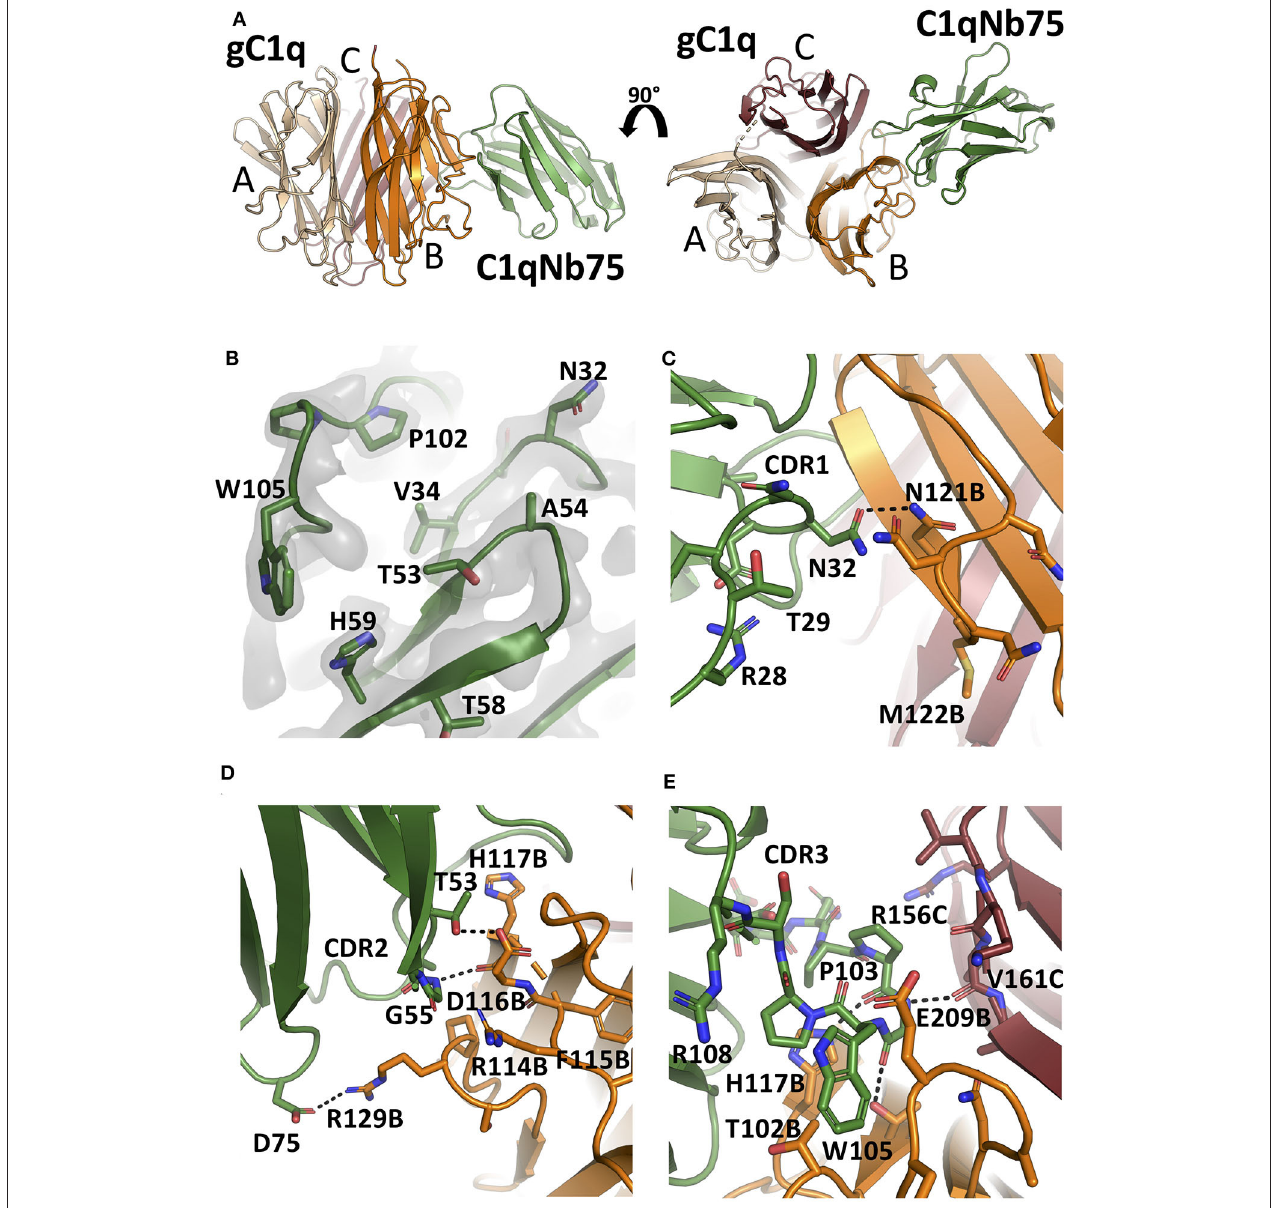
FIGURE 4 | The crystal structure of the gC1q-C1qNb75 complex reveals the epitope. (A) Side view (left) and top view (right) of the gC1q-C1qNb75 complex. The different subunits of gC1q are colored in wheat (A-chain), orange (B-chain) and brown (C-chain) whereas C1qNb75 is displayed in green. (B) Omit 2mF o -DF c electron density map contoured at 1.2 σ around the three CDRs. Residues shown with side chains in sticks were omitted for map calculation. (C–E) The interface between gC1q and C1qNb75 with selected residues shown in sticks. (C) CDR1 contacts, (D) CDR2 contacts, (E) CDR3 contacts. Hydrogen bonds are shown with black dashes. The gC1q residues are labeled with their chain identifier as